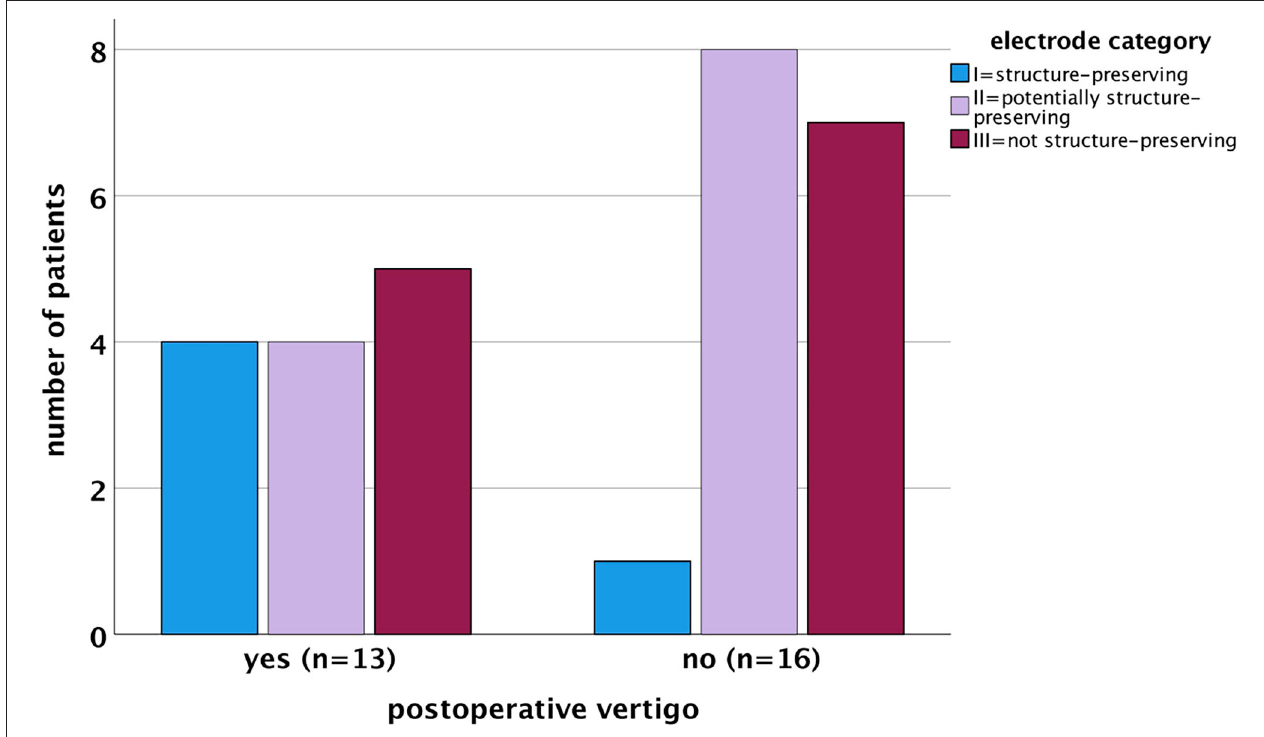
FIGURE 4 | Correlation between the occurrence of postoperative vertigo and electrode categories (bar chart). The electrode categories were not normally distributed in patients with postoperative vertigo ( p = 0.007) as well as in patients without postoperative vertigo ( p = 0.001) as assessed by the Shapiro–Wilk test.